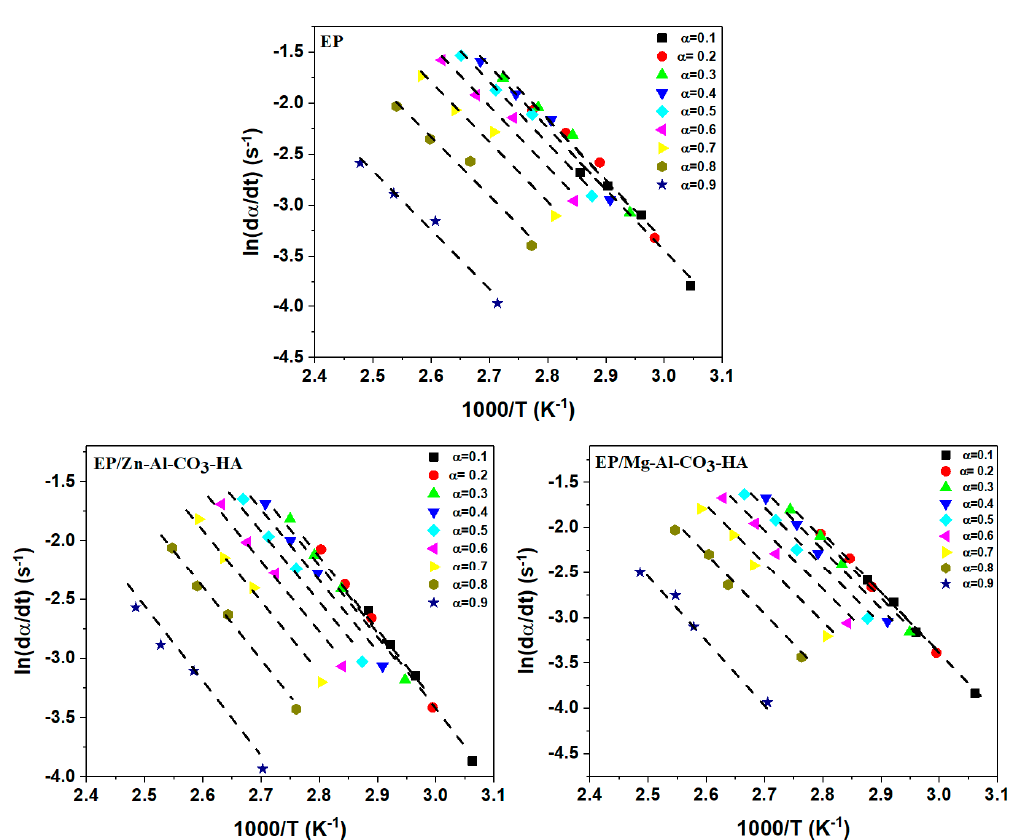
Figure A1. Fitting plots for the neat epoxy and its nanocomposites based on the Friedman model.